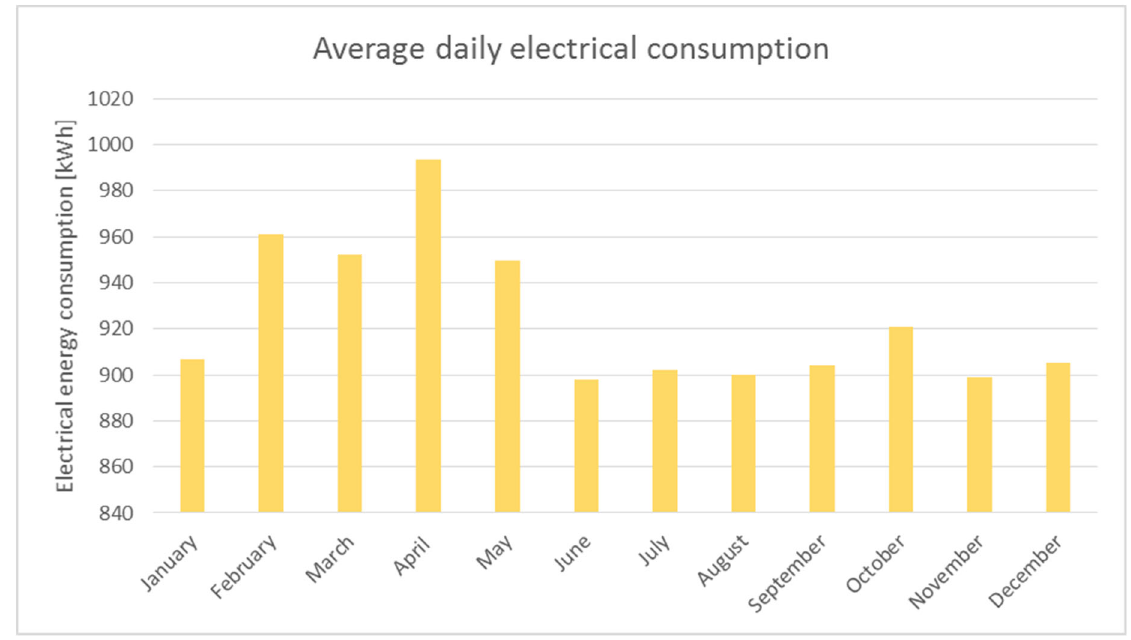
Figure 16. Daily average energy consumption, month by month.